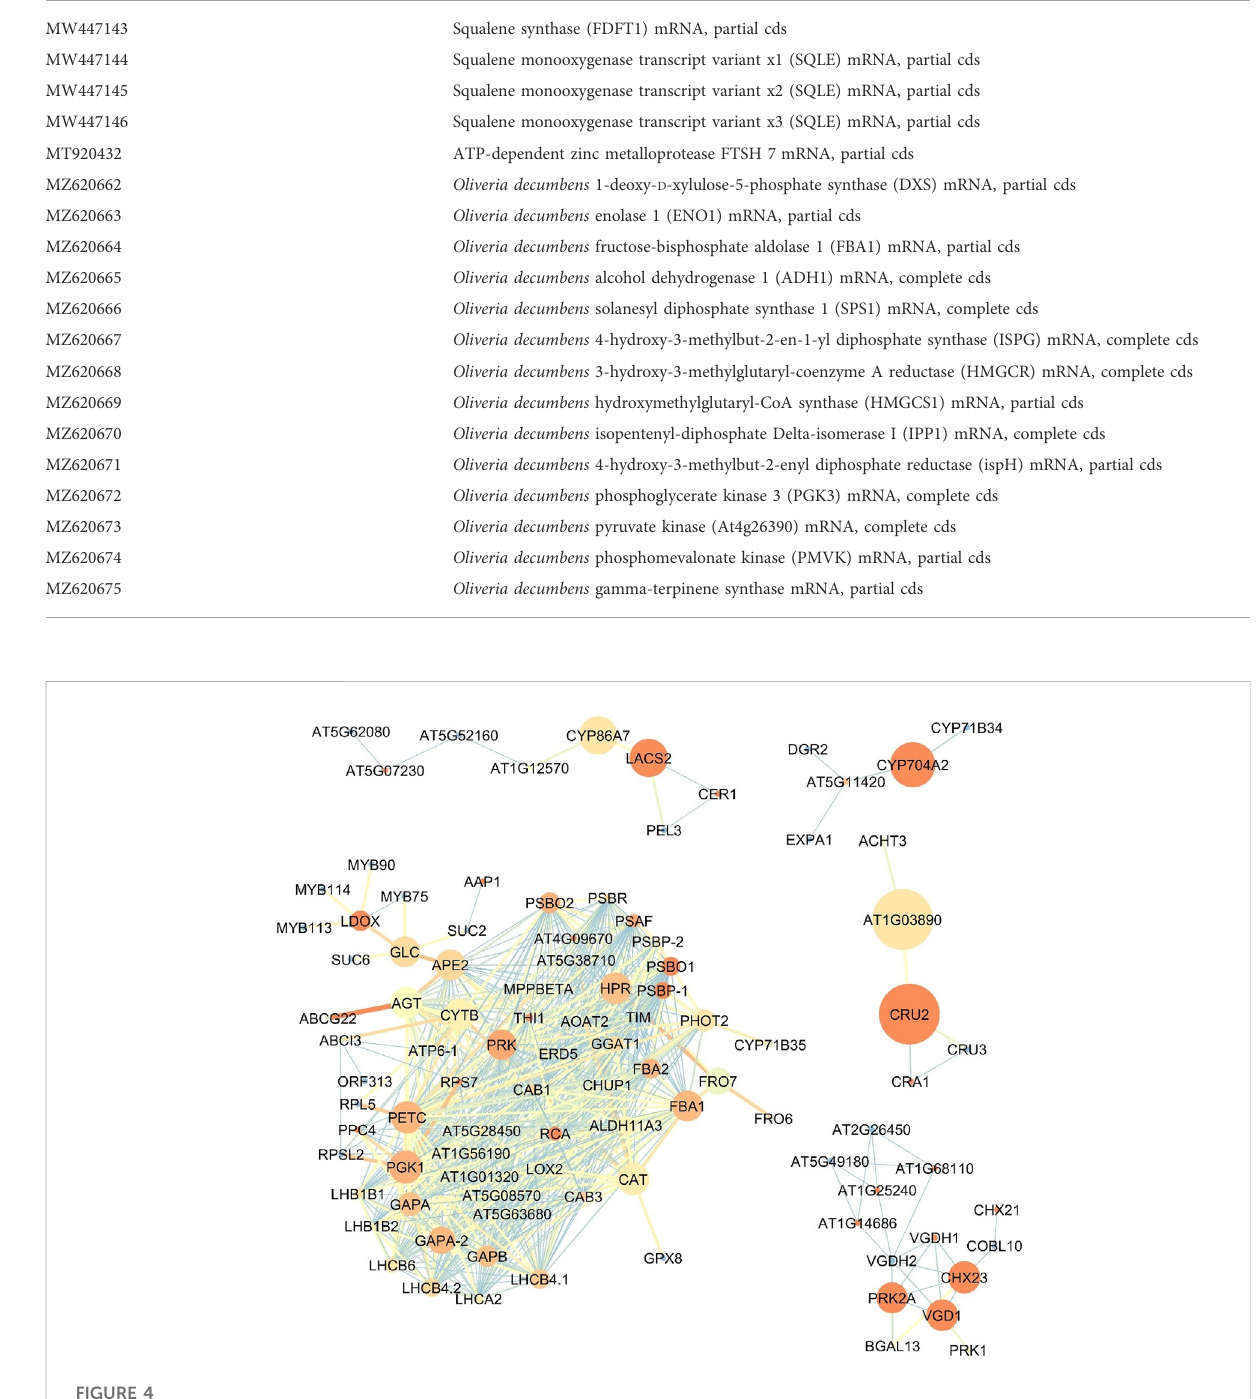
FIGURE 4 The co-expression network of upregulated genes in the fl ower of Oliveria decumbens Vent. The bigger size of the node is representative of higher betweenness centrality and thedarker the red color is representative thehigher the Closeness centrality and blueish color showing the lower closeness centrality in the network. Also, the thicker and more reddish connective line, represents the higher Edge Betweenness; the thinner and tending to light blue color showing the lower edge